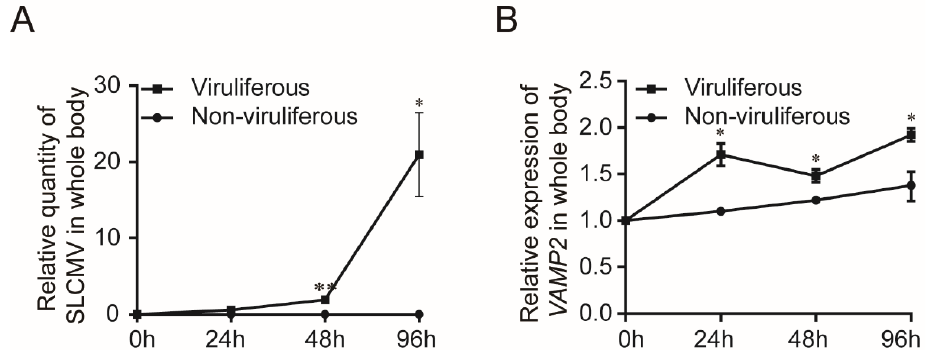
Figure 6. Effect of SLCMV infection on the transcription of BtVAMP2 . Analyses were conducted